Question: Summarize what this figure shows in one sentence.
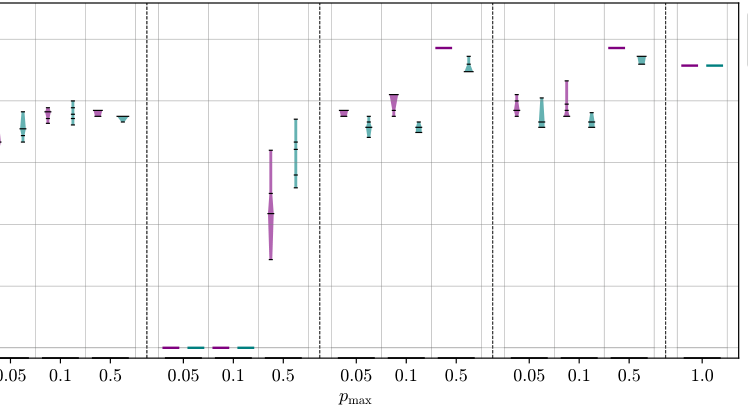
Answer: Synthetic data, 10 nodes, F1.